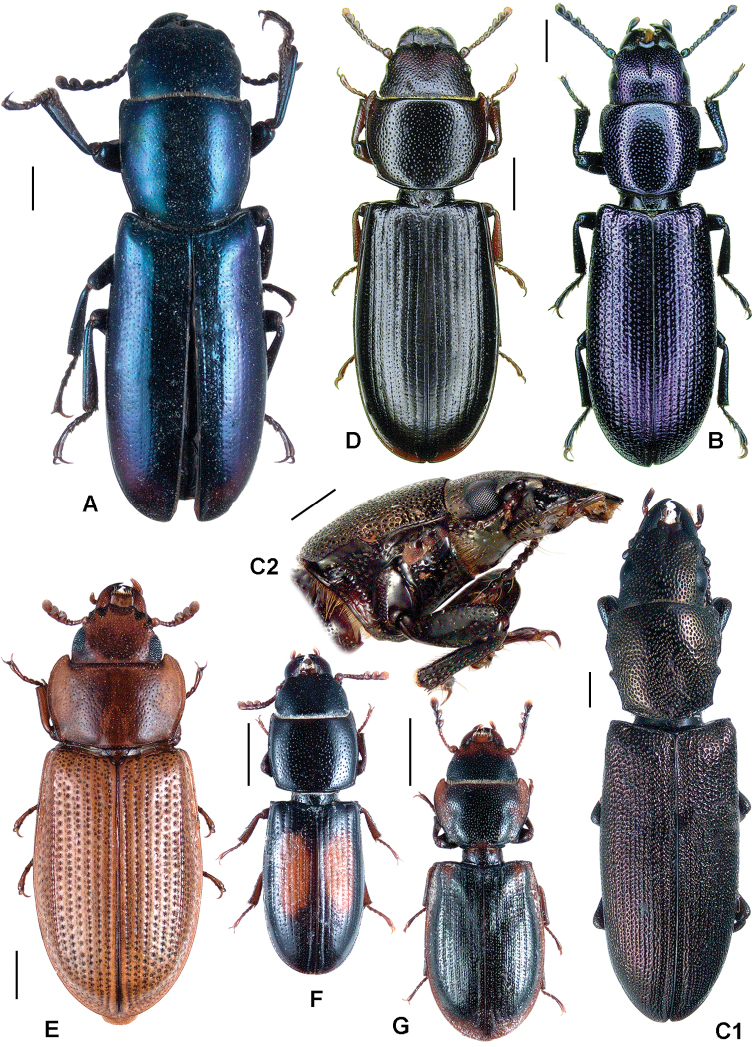
A
Temnoscheila smaragdina
B
Temnoscheila caerulea
C
Temnoscheila punctatissima
D
Tenebroides mauritanicus
E
Tenebroides ruber
F
Tenebroides bipustulatus
G
Tenebroides fossulatus.